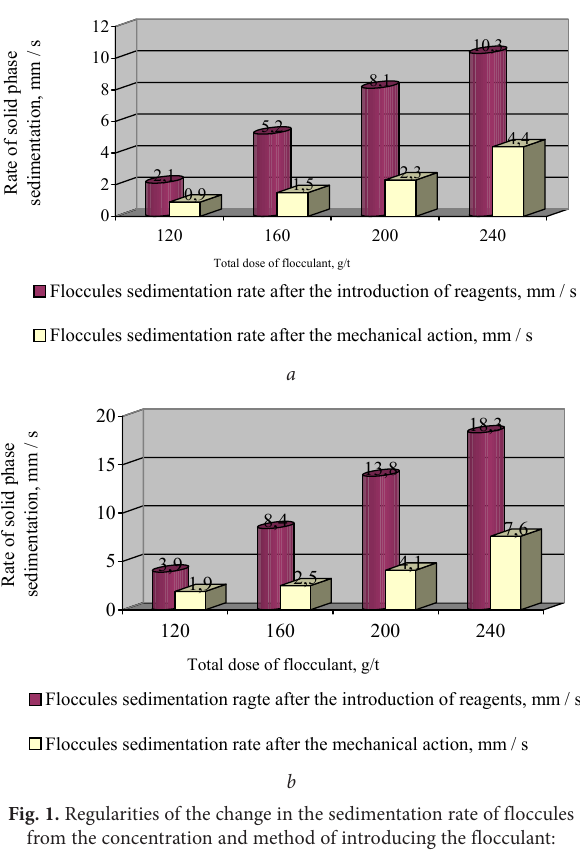
Fig. 1. Regularities of the change in the sedimentation rate of floccules from the concentration and method of introducing the